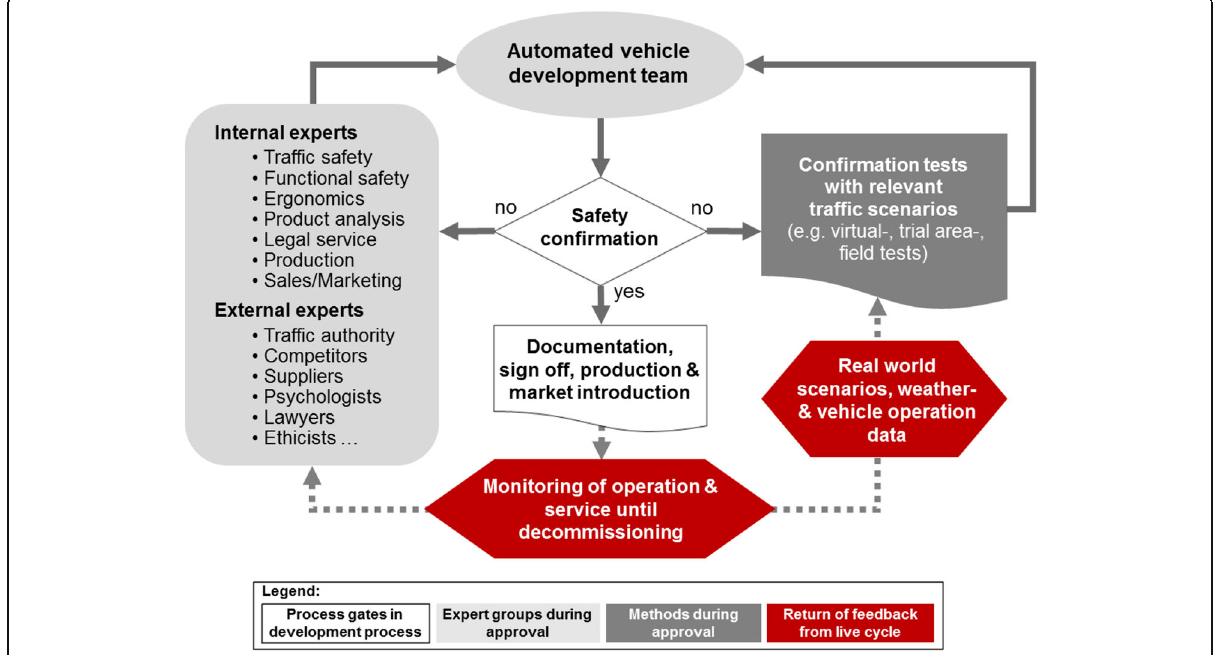
Fig. 1 Feedback from lifecycle of automated vehicles for safe development, validation and ethical testing